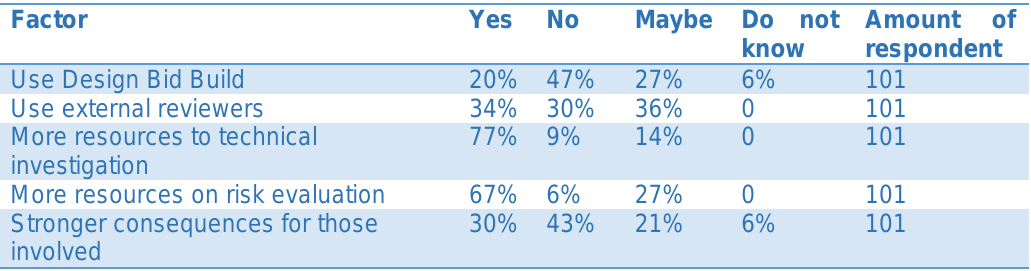
Table 8: Simplified overview of the results Factor